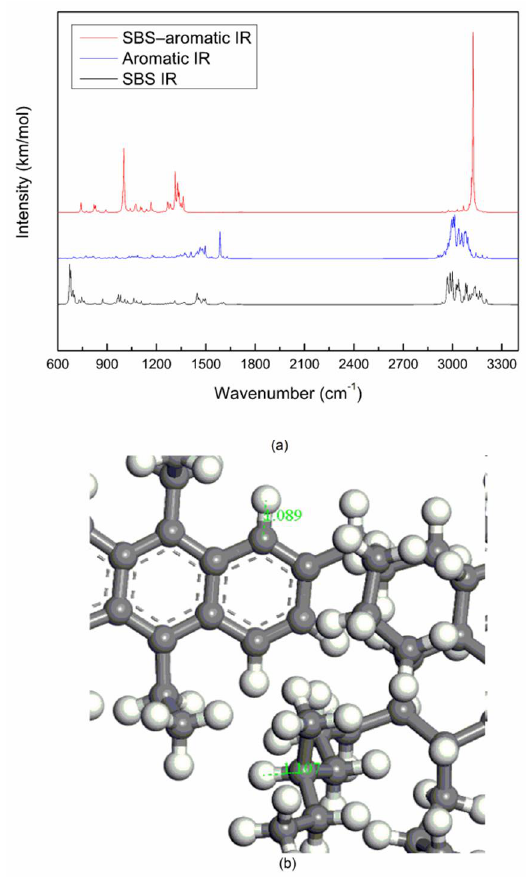
Figure 4. Molecular vibrational spectrums and bond length: ( a ) SBS IR, aromatic IR, SBS–aromatic IR; ( b ) C–H bond length of aromatic. Table 3. Assignations of the bands of the aromatic molecule vibration spectrum.